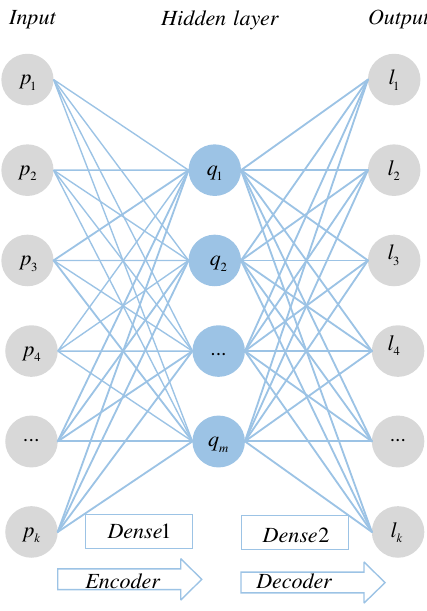
Figure 3. Structure of autoencoder network.